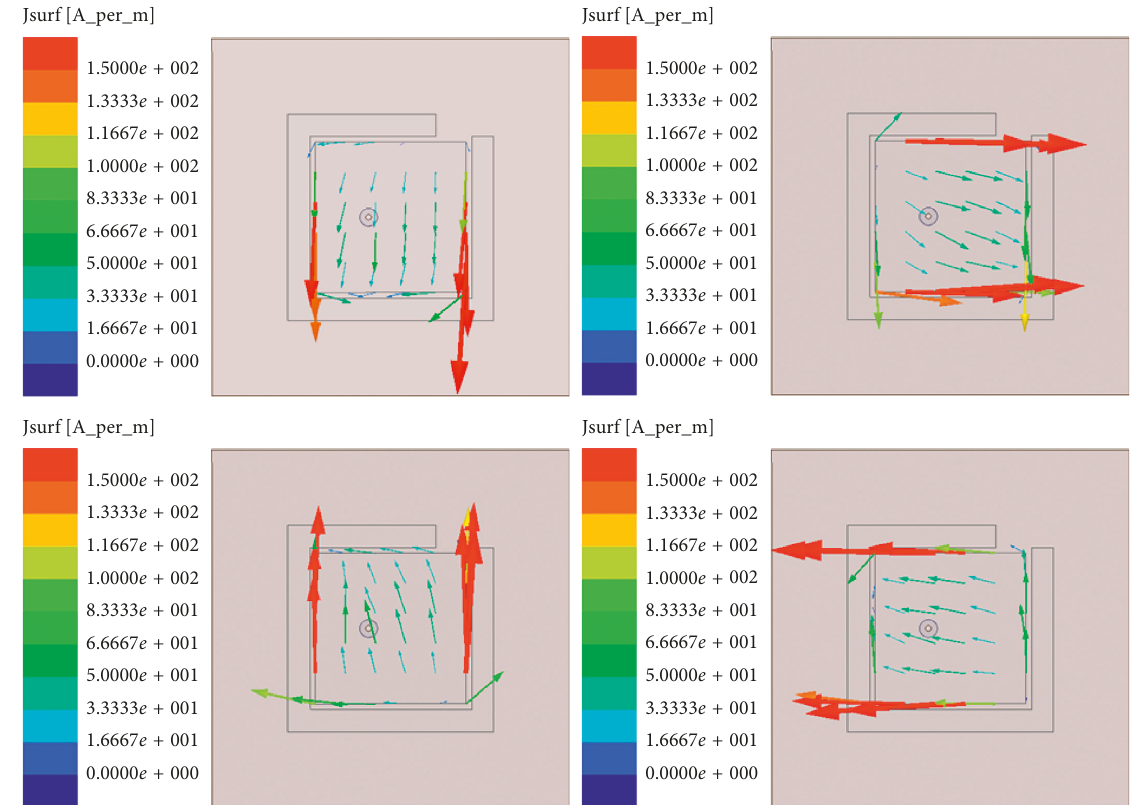
Figure 3: The surface current distribution showing RHCP behavior of the antenna with the mirrored parasitic strip at 1.65 GHz.